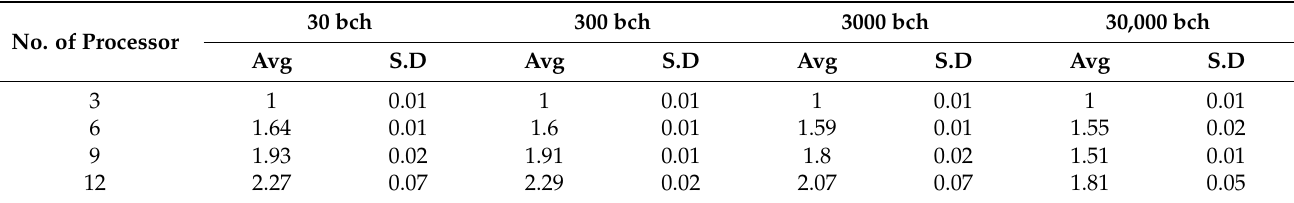
Table 7. Speedup factor. Based on three processors, as the number of processors increased to 6, 9, and 12, the comparison was made. In order to exclude the effect of the difference in performance between nodes, the entire processor was evaluated by adding one from each node. The results of five iterations were averaged. Avg means the average value at this time, and SD means the standard deviation of the measured